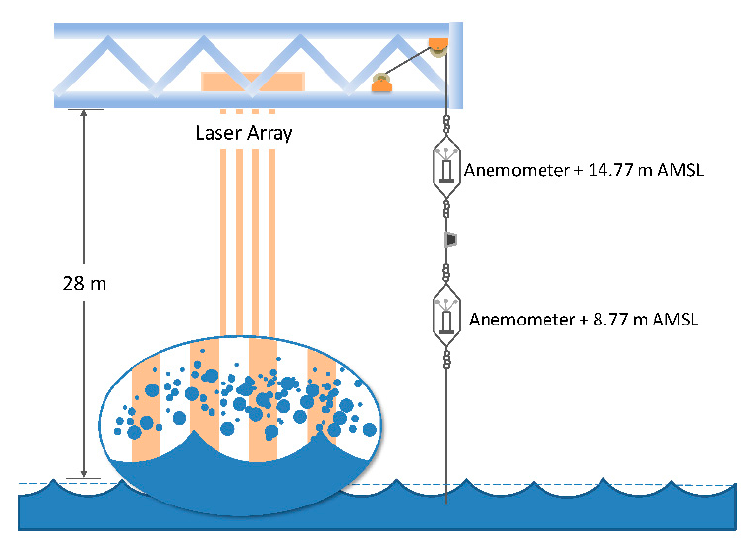
Figure 2. Configuration of the observation platform and instruments. The rectangular laser array is attached to the flare bridge 28 m above MSL. Two anemometers are fixed at 8.77 m and 14.77 m above the MSL, respectively.